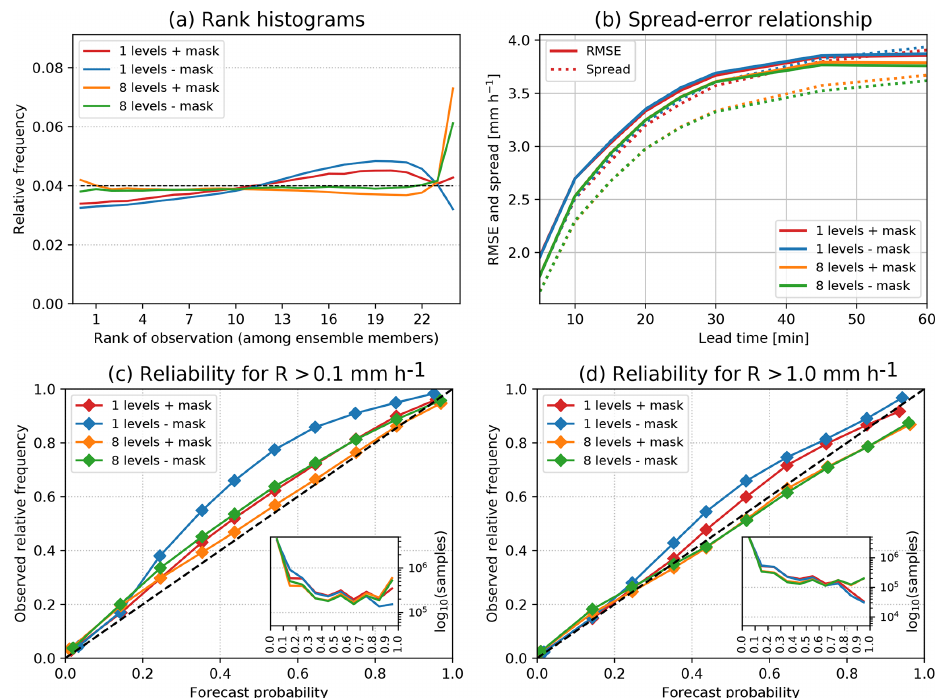
Figure 19. Ensemble and probabilistic verification of the cascade experiments for all the MeteoSwiss cases with and without cascade decomposition, and with and without masking. (a) Rank histograms at 60min, (b) spread–error relationship, (c, d) reliability diagrams at 60min for probability of rain exceeding 0.1 and 1mmh − 1 ,